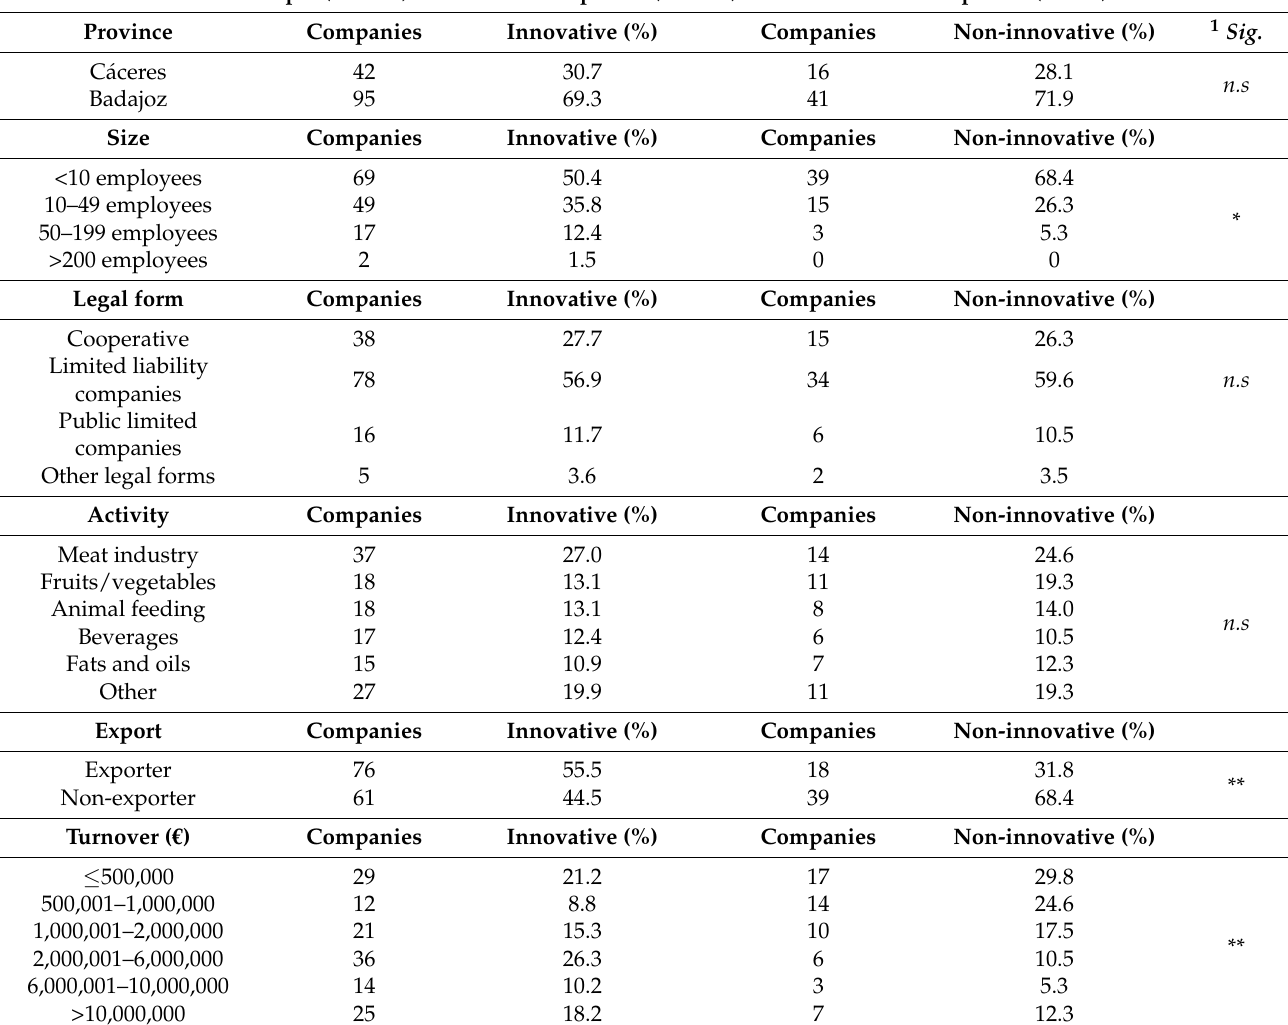
Table 2. Comparison of the characteristics of innovative and non-innovative